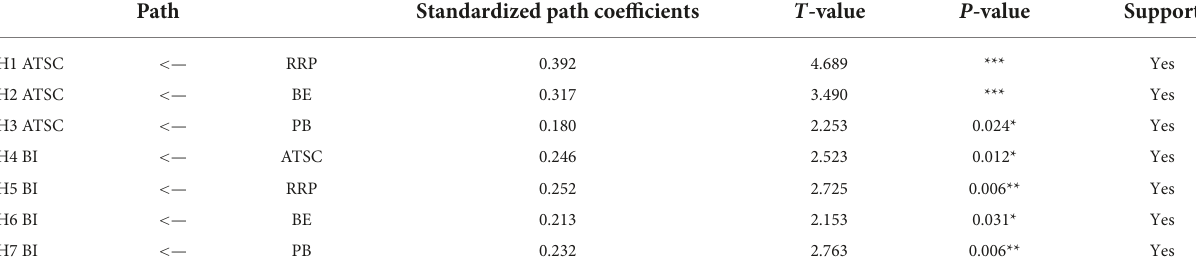
TABLE 7 Path coefficients between